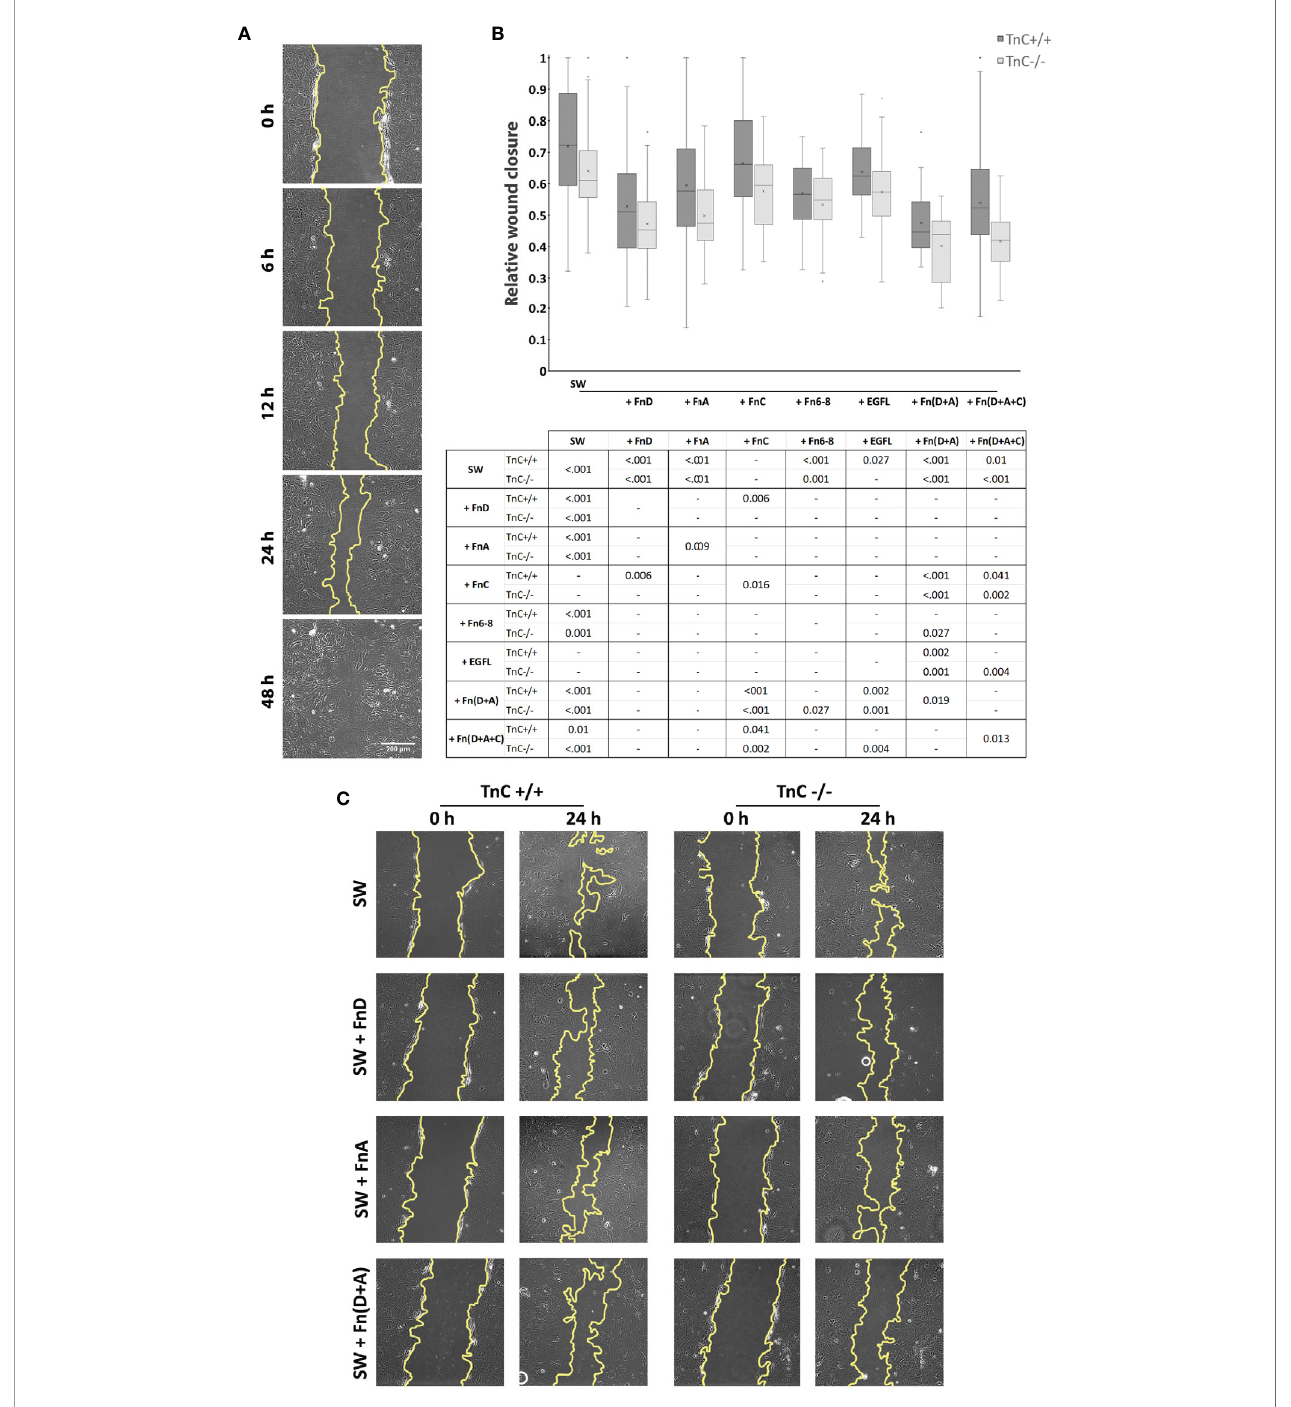
FIGURE 1 | TnC fragments attenuate wound closure in cultured astrocytes. (A) Representative bright fi eld images of fi ve time points of the gap area measured in the ImageJ program. (B) Relative wound closure is presented in a box-and-whisker plot indicating the impact of TnC fragments on gap closure in TnC+/+ and TnC-/- cortical astrocyte cultures after 24 h. Two-way ANOVA analysis shows no interaction between genotype and treatment, but both the effects of treatment and genotype were signi fi cantly different ( p < 0.001). The most potent effect was produced by FnA, FnD, and combinations Fn(D+A) and Fn(D+A+C) in both genotypes. All pairwise signi fi cance comparisons are given in the table below the box-and-whisker plot. n = 3 independent astrocyte culture preparations. (C) Representative images of the gap at 0 and 24 h after scratching in the control group (SW) and groups treated with FnA, FnD, and